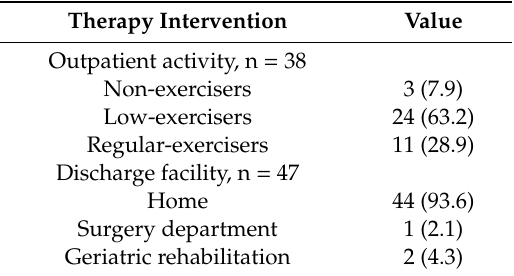
Table 2. Outpatient activity level and discharge